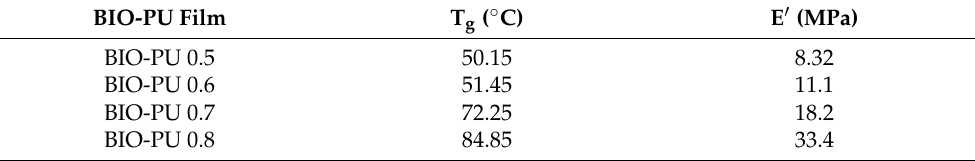
Table 4. Glass transition (T g ) temperature and storage modulus of BIO-PU